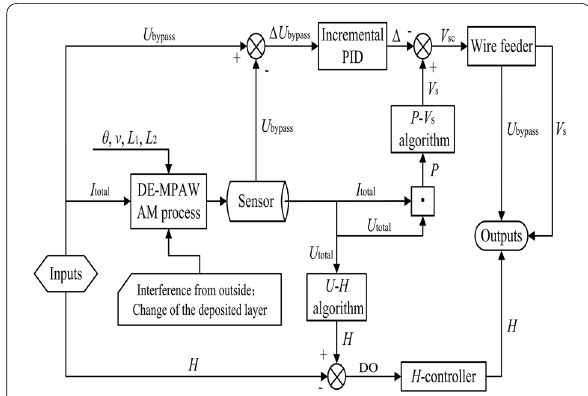
Figure 10 Circuit of DE-MPAW system corresponding to droplet-transfer model